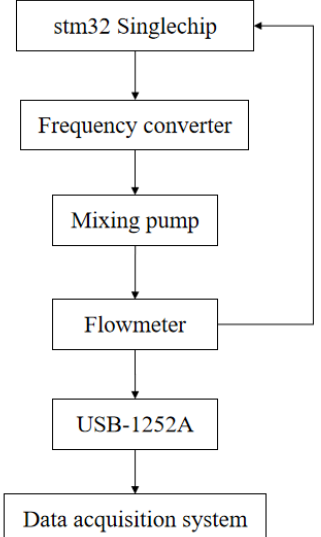
Figure 11. Schematic diagram of data acquisition and control